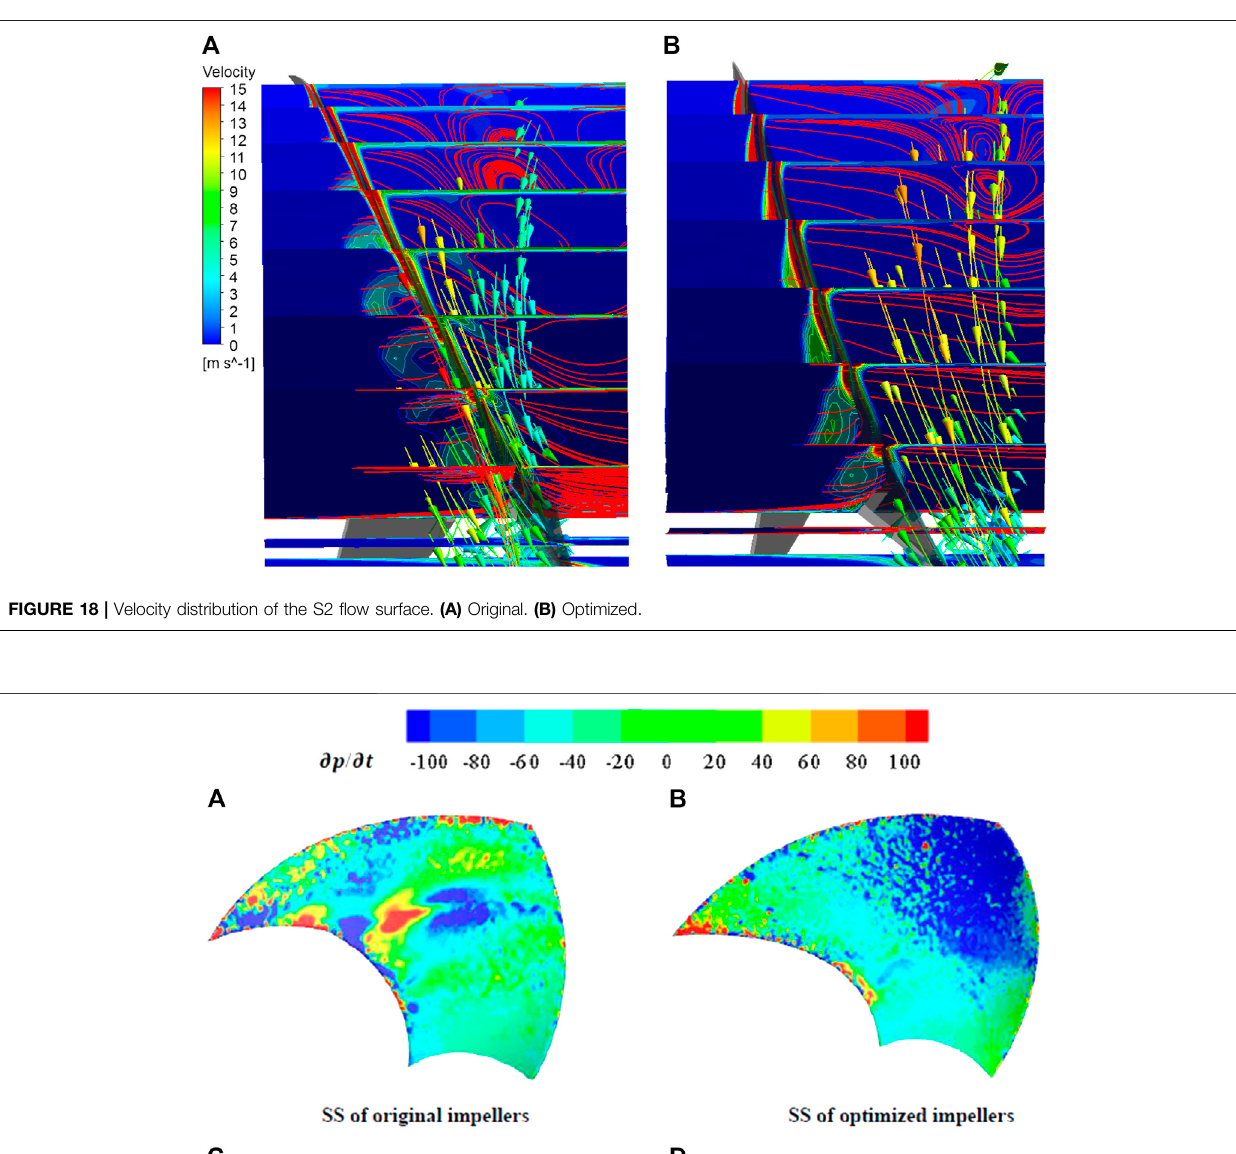
Frontiers in Energy Research |